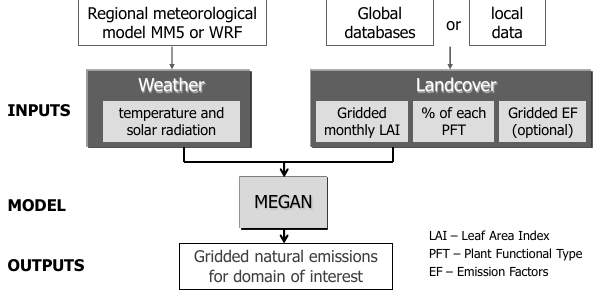
Fig. 2. MEGAN model structure including Input/Output informa-